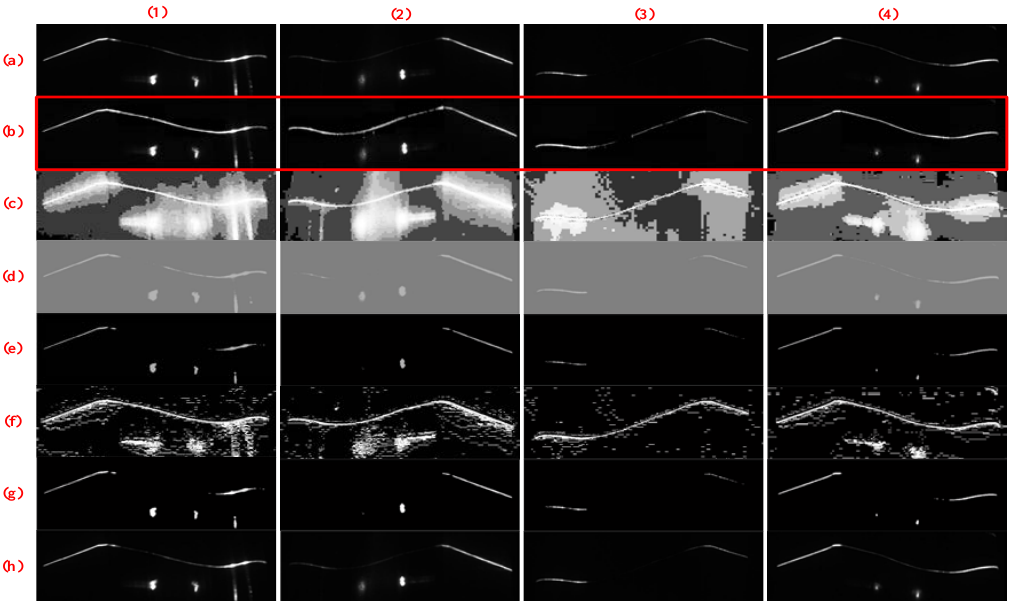
Figure 13. Enhanced results of outer stripe images based on different methods. Columns ( 1 )–( 4 ) present the tread segments with different missing percentages. Row ( a ) displays the raw images. Rows ( b – h ) exhibit the results processed by HE, CA, LT, CF, MF, and SO methods, respectively, and row ( b ) shows the results generated through the proposed method. Sensors 2018 , 18 , x FOR PEER REVIEW 15 of 20